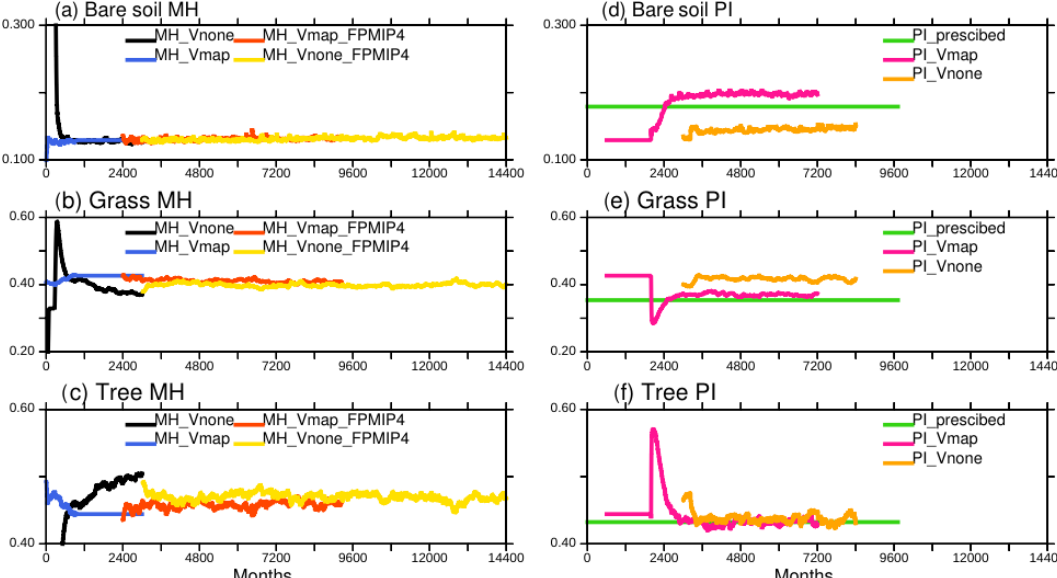
Figure 4. Long-term adjustment of vegetation for the Mid-Holocene (MH) (a, b, c) and preindustrial (PI) climate (c, d, e) , when starting from bare soil (Vnone) or from a vegetation map (Vmap). The 13 ORCHIDEE PFTs have been gathered as bare soil, grass, trees, and land use. When the dynamical vegetation is active, only natural vegetation is considered. Land use is thus only present in one simulation, corresponding to a preindustrial map used as a reference in the IPSL model (Dufresne et al., 2013). The corresponding vegetation is referred to as PI_prescribed. The x axis is in months, starting from 0, which allows us to plot all the simulations that have their own internal calendar on the same